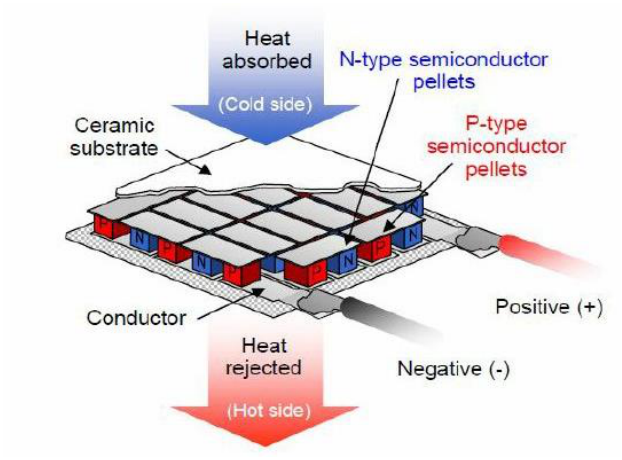
Figure 1: The semiconductor thermoelectric cooler with hot and cold sides